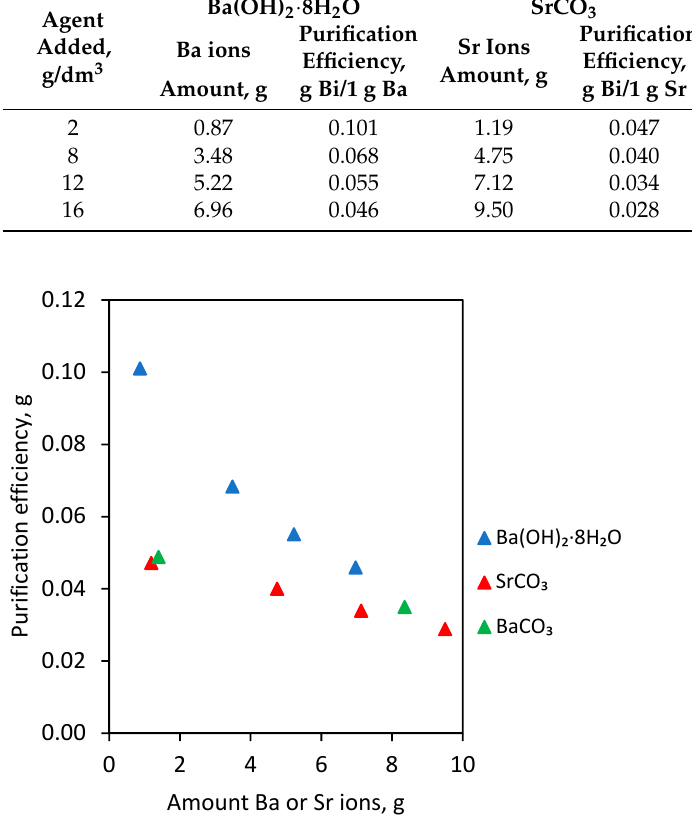
Table 3. Bi amount removed in grams per 1 g Ba or Sr ions (purification efficiency) depending on the type and amount of agent added into S4 electrolyte.